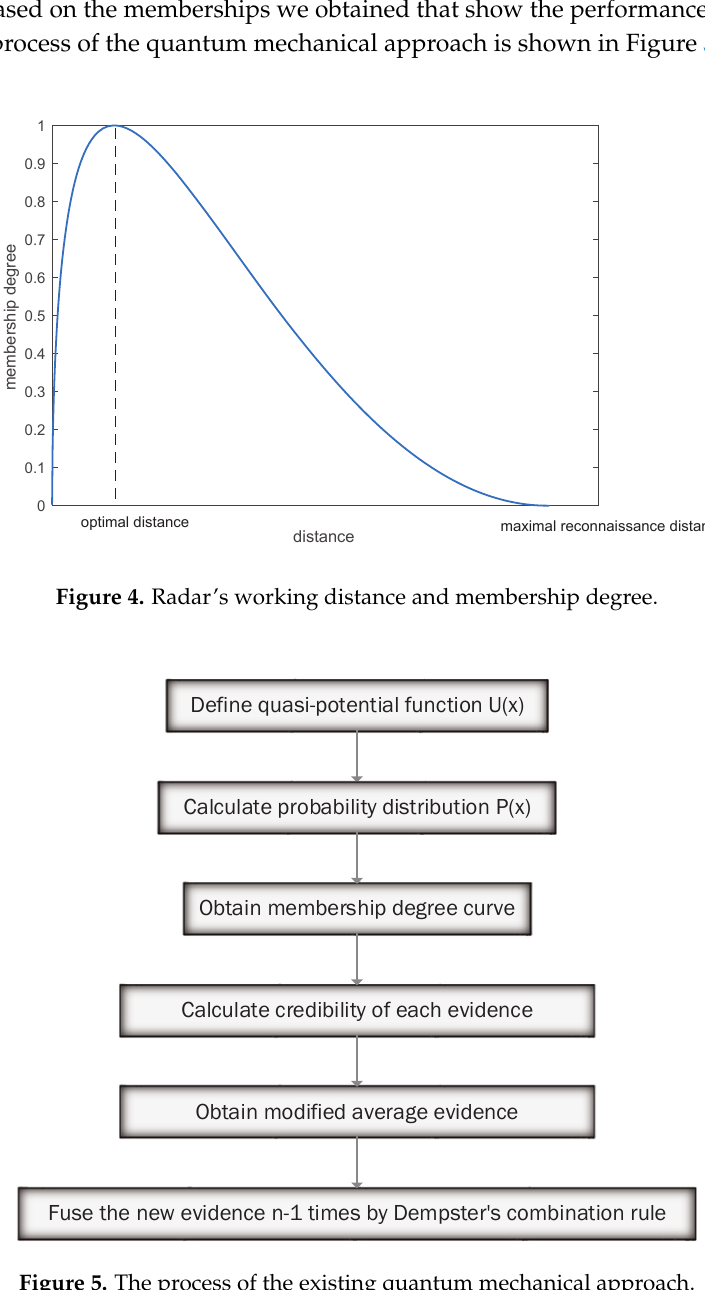
Figure 5. The process of the existing quantum mechanical